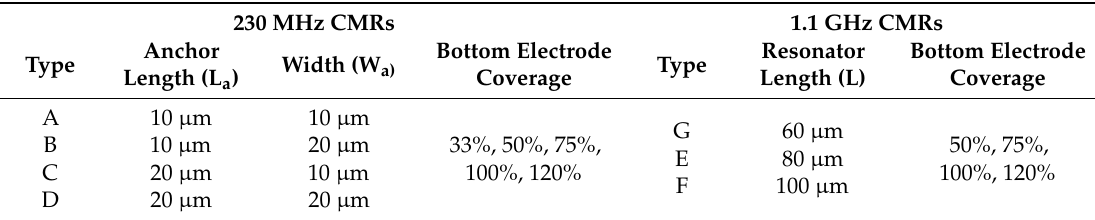
Figure 1. ( a ) Side view of an aluminum nitride (AlN) contour-mode resonator (CMR). The resonator is formed of top electrodes, an AlN layer, and a bottom electrode. ( b – e ) The fabrication process consists of a bottom electrode patterning, AlN deposition, top electrode deposition, and the final device release via XeF 2 etching of a silicon layer. ( f ) A schematic of 220 MHz CMR consisting of the anchor, bus region, top and bottom electrodes, and silicon substrate. The bottom electrode coverage rate is defined as the bottom electrode area (pink) divided by the area where the top electrodes overlap (green). Table 1. Parameters of fabricated 230 MHz and 1.1 GHz CMRs with various anchor designs and bottom electrode coverage rates. 230 MHz CMRs